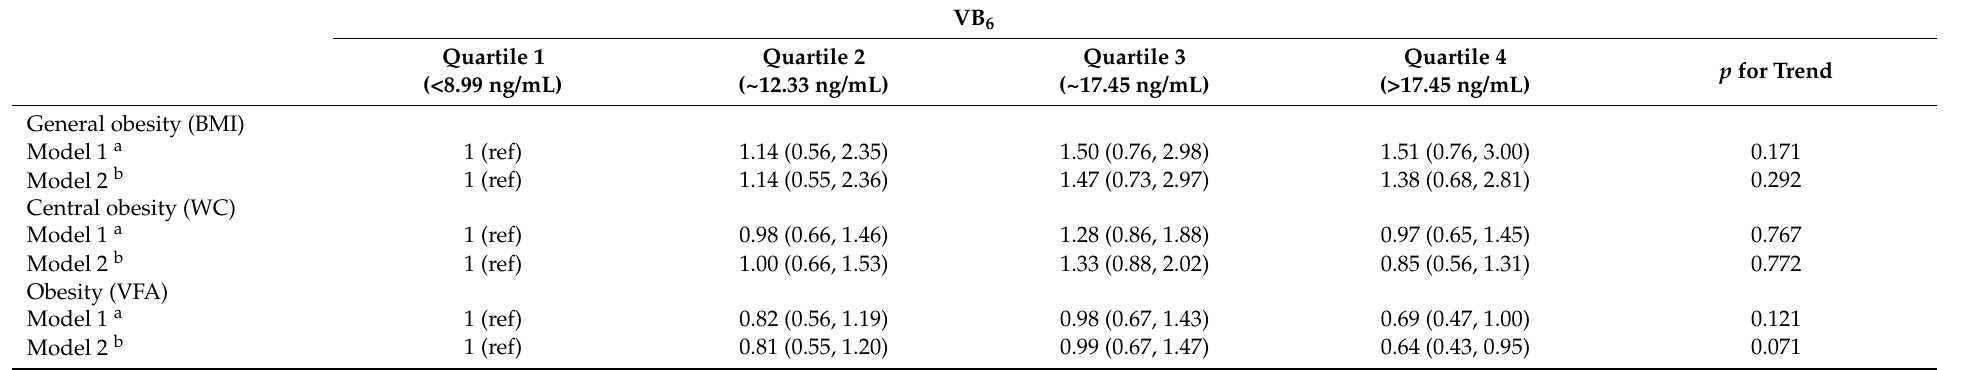
Table 6. Association between vitamin B 6 and obesity according to different obesity